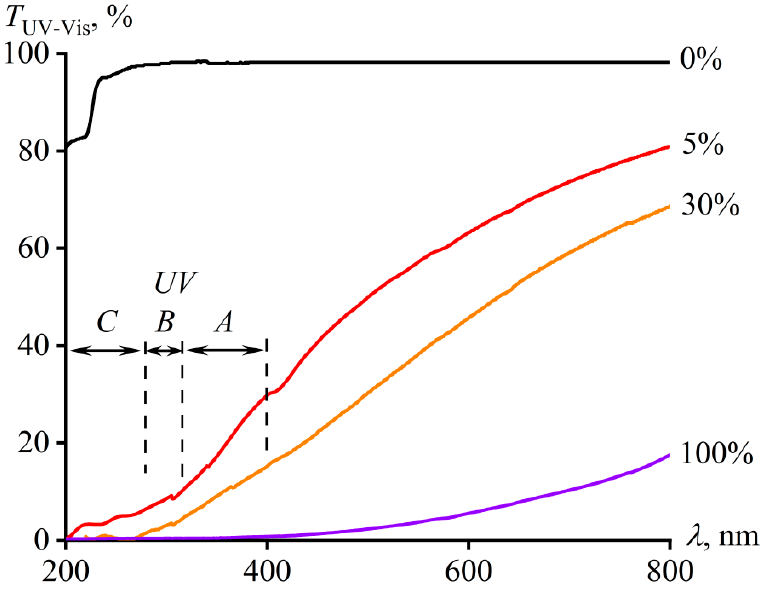
Figure 10. The dependence of the transmittance on the wavelength of electromagnetic radiation for PIB, asphaltenes, and their mixtures. The mass fraction of asphaltenes is indicated at the curves.